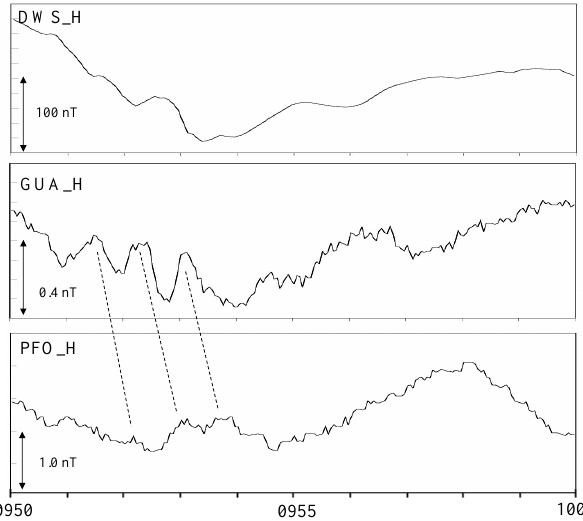
Figure 10. From top to bottom: plot of the waveform of H for DWS, GUA, and PFO for the intervals from 09:50UT to 10:00UT. A pos- sible delay of the waveform of PFO with respect to GUA is marked by a dotted